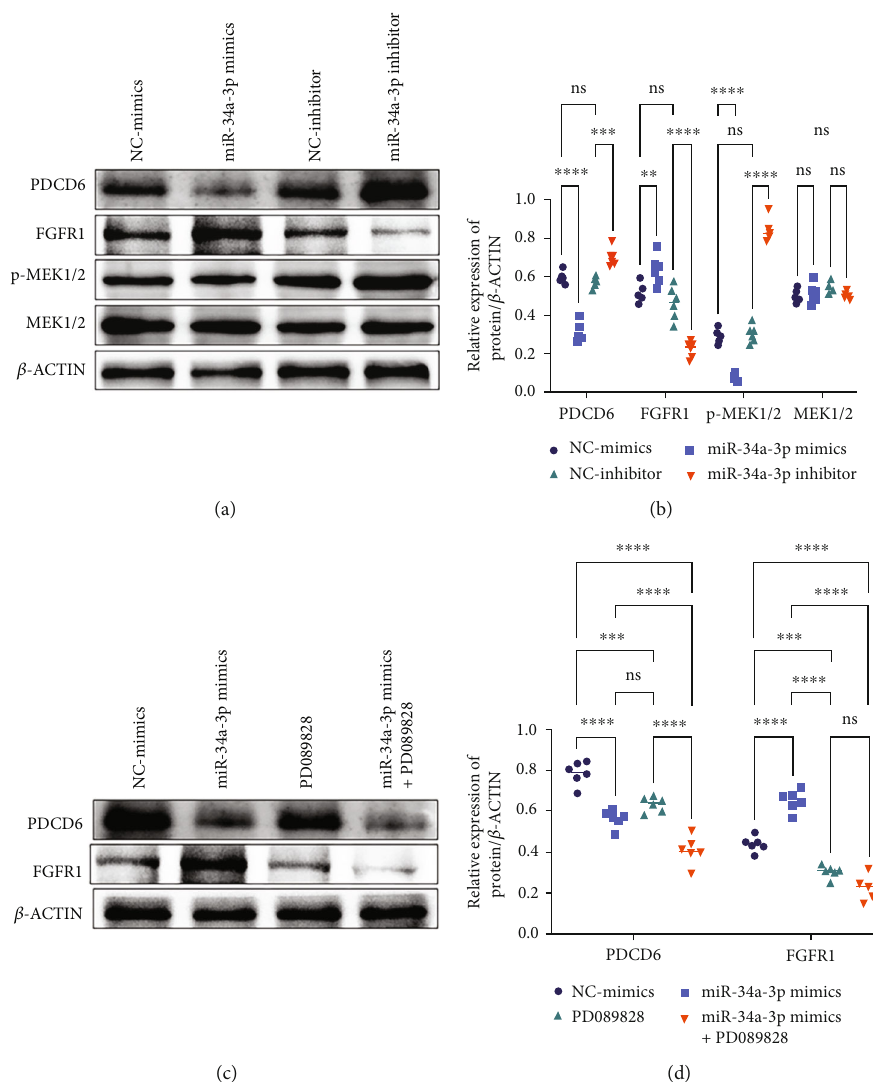
Figure 3: miR-34a-3p might regulate NSCs through FGFR1 or MEK1/2 signaling. (a, b) Western blot analyses and quanti fi cation showing the expression of FGFR1 and PDCD6 MEK1/2 and p-MEK1/2 after miR-34a mimic or inhibitor treatments. (c, d) Western blot analyses and quanti fi cation of PDCD6 and FGFR1 protein expression levels after treatment with miR-34a-3p mimic or PD089828 (a competitive inhibitor of FGFR1) or their combined treatment. The experiments were performed in triplicate and repeated six times ( n = 6 ); representative images of three independent experiments were presented. Two-way ANOVA followed by the Š ídák ’ s multiple comparisons test was utilized to identify di ff erences. ∗ p < 0 : 05 , ∗∗ p < 0 : 01 , ∗∗∗ p < 0 : 001 , ∗∗∗∗ p < 0 : 0001 , and ns: nonsigni fi cant among the compared